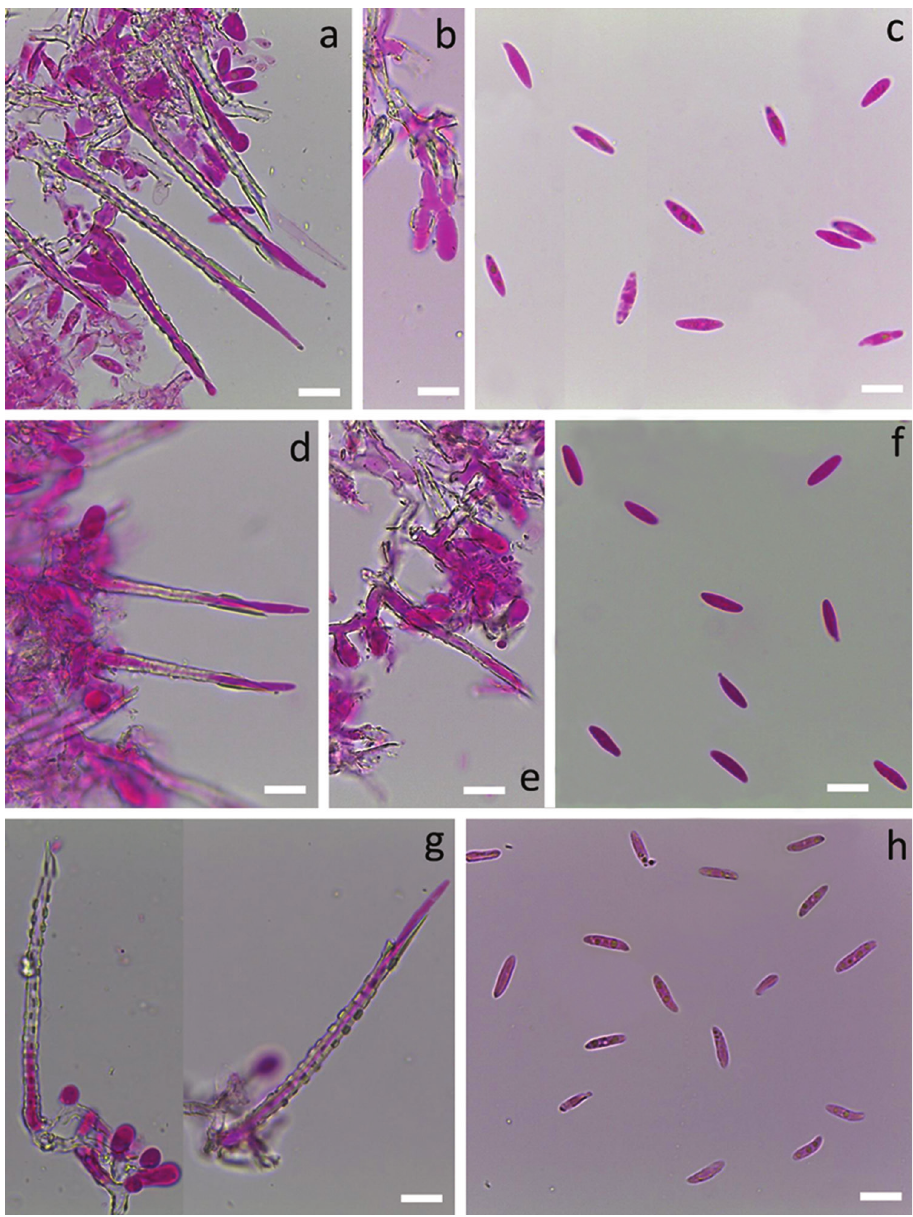
Figure 4. Species of Subulicystidium with narrow fusiform basidiospores. Subulicystidium fusisporum (GB:KHL 10360, holotype): a cystidia b crystalline encrustation of hymenium c basidiospores. Subu- licystidium inornatum (GB:KHL 10444, holotype): d cystidia e young hymenium with slight overall encrustation f basidiospores. Subulicystidium tedersooi (TU 110894, holotype): g cystidia, h basidiospores. All preparations done in 3% aqueous solution of potassium hydroxide (KOH) mixed with 1% aqueous solution of Phloxine. All scale bars equal 10